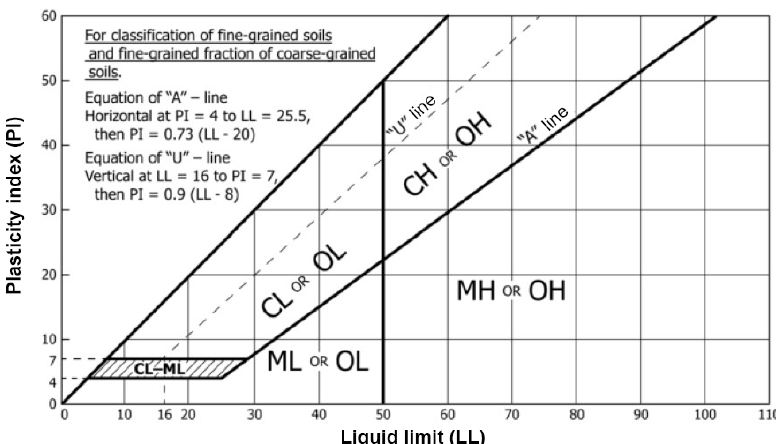
Figure 3. Plasticity chart. CL: lean clay. ML: silt. CH: fat clay. MH: elastic silt. CL-ML: silty